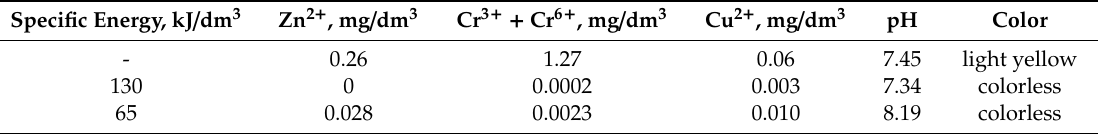
Table 2. The e ffi ciency of galvanic purification in the process of changing the specific energy. Specific Energy, kJ / dm 3